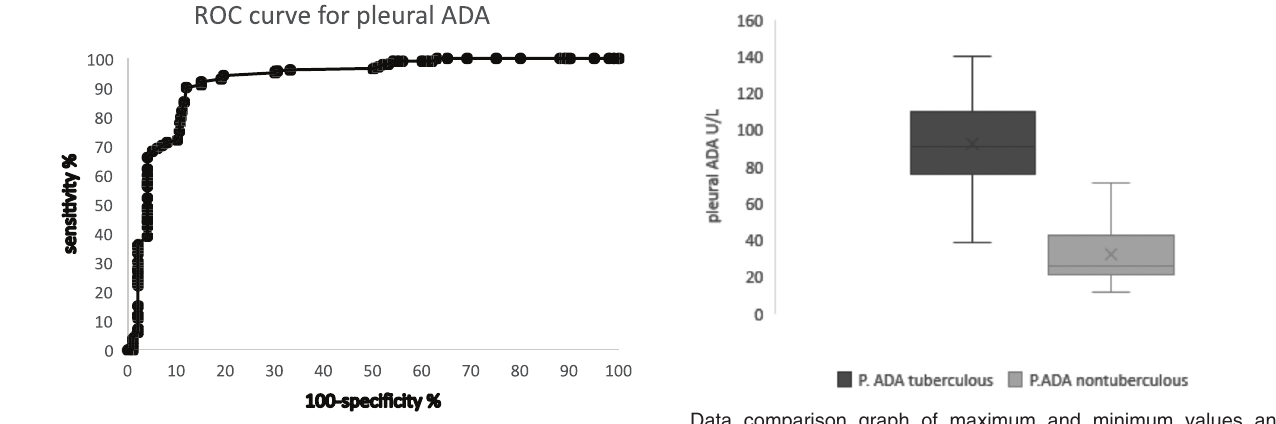
The receiver operator characteristic (ROC) curves for adenosine deaminase (ADA). The area under the curve (AUC) for cutoff 40U/l was 0.91.